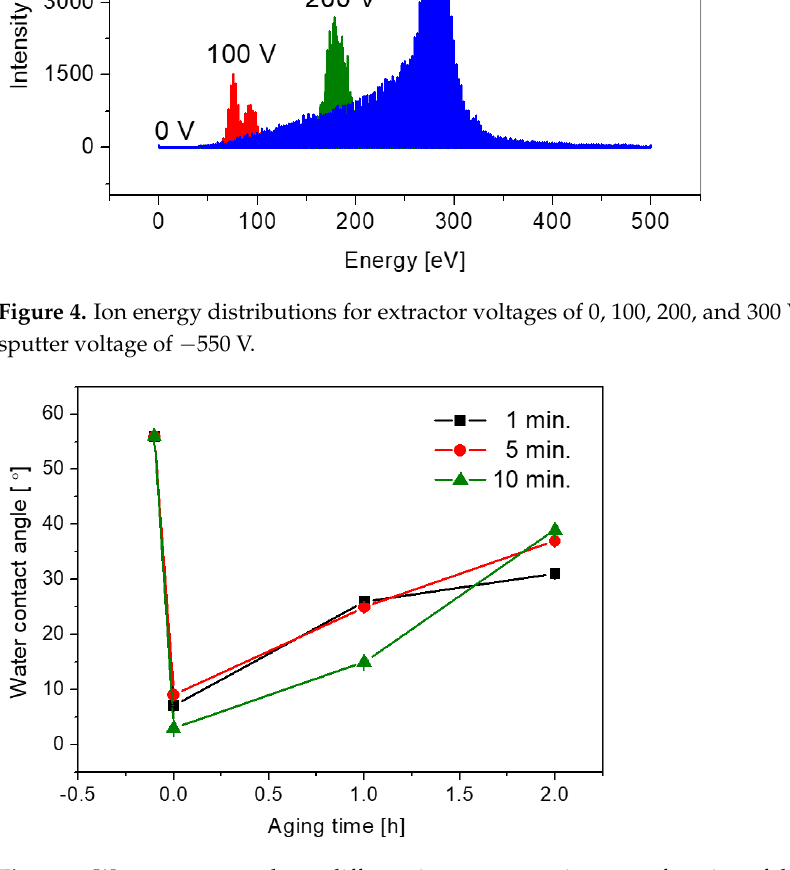
Figure 5. Water contact angles at different ion treatment times as a function of the aging time.